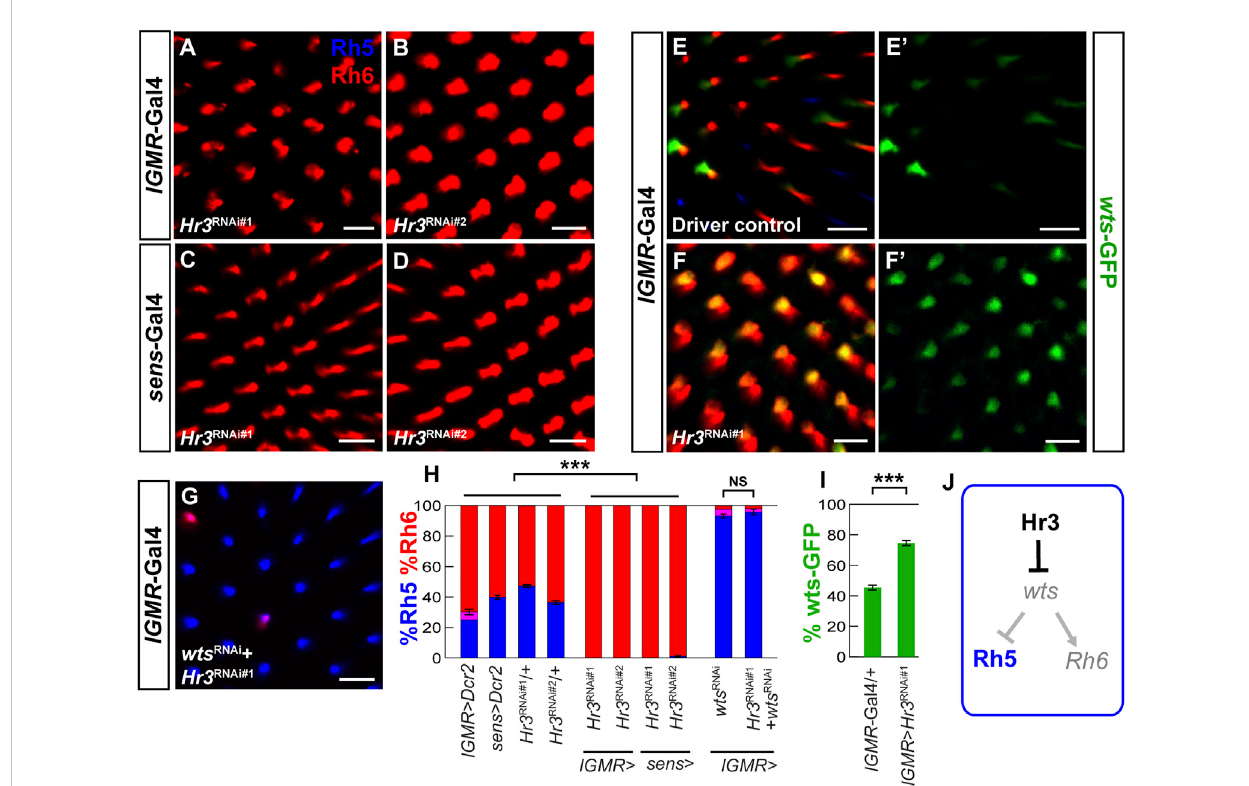
Hr3/ROR β is required to repress warts and to specify Rh5 fate. (A,B) Pan-photoreceptor knockdown of Hr3 using two separate RNAi constructs, TRiP #27253 ( Hr3 RNAi#1 )andTRiP #27254 ( Hr3 RNAi#2 )causesacompletelossofRh5andgainofRh6. (C,D) R8photoreceptorknockdownwithtwoseparateRNAi constructs also causes a dramatic loss of Rh5 and gain of Rh6. (E,E 9 ) In the heterozygous lGMR-Gal4 /+ driver control, the wts- GFP transcriptional reporter is expressed in most Rh6 photoreceptors. (F, F 9 ) Pan-photoreceptor knockdown of Hr3 causes a de-repression of the wts- GFP reporter together with Rh6. (G) Pan-photoreceptor knockdown of both Hr3 and wts causes a gain of Rh5 and loss of Rh6, resembling the wts knockdown phenotype. All scale bars, 10 µm. (H) Quanti fi cation of R8 subtypes in controls and Hr3 knockdowns. Mean %Rh6 was compared among genotypes with an ANOVA and a post hoc Tukey HSD Test; *** p < 0.0001. 5-8 retinas were scored for each genotype. (I) Quanti fi cation of the GFP-expressing R8photoreceptorsinthedrivercontroland Hr3 knockdown.Mean% wts-